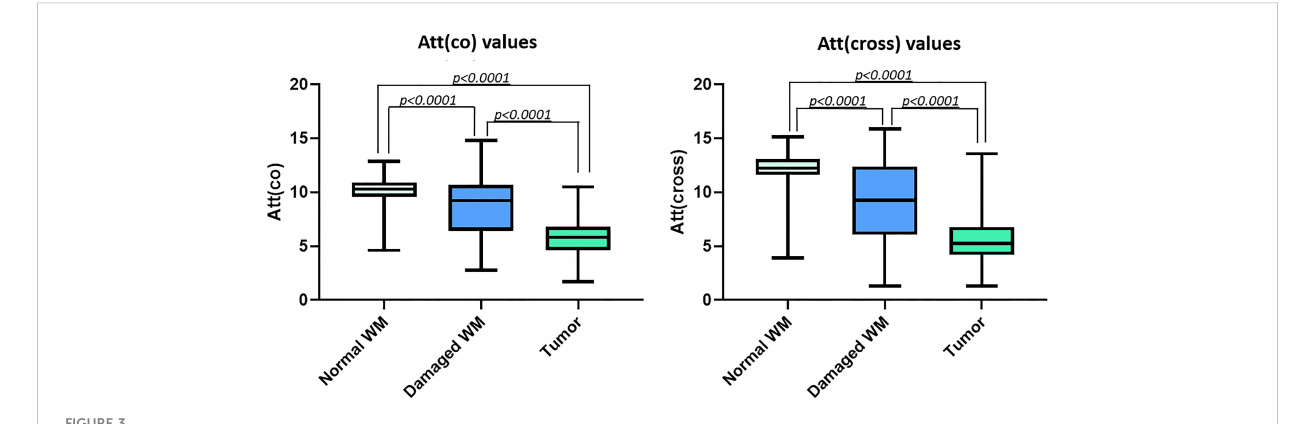
FIGURE 3 Distributions of Att(co) and Att(cross) values for the studied tissue